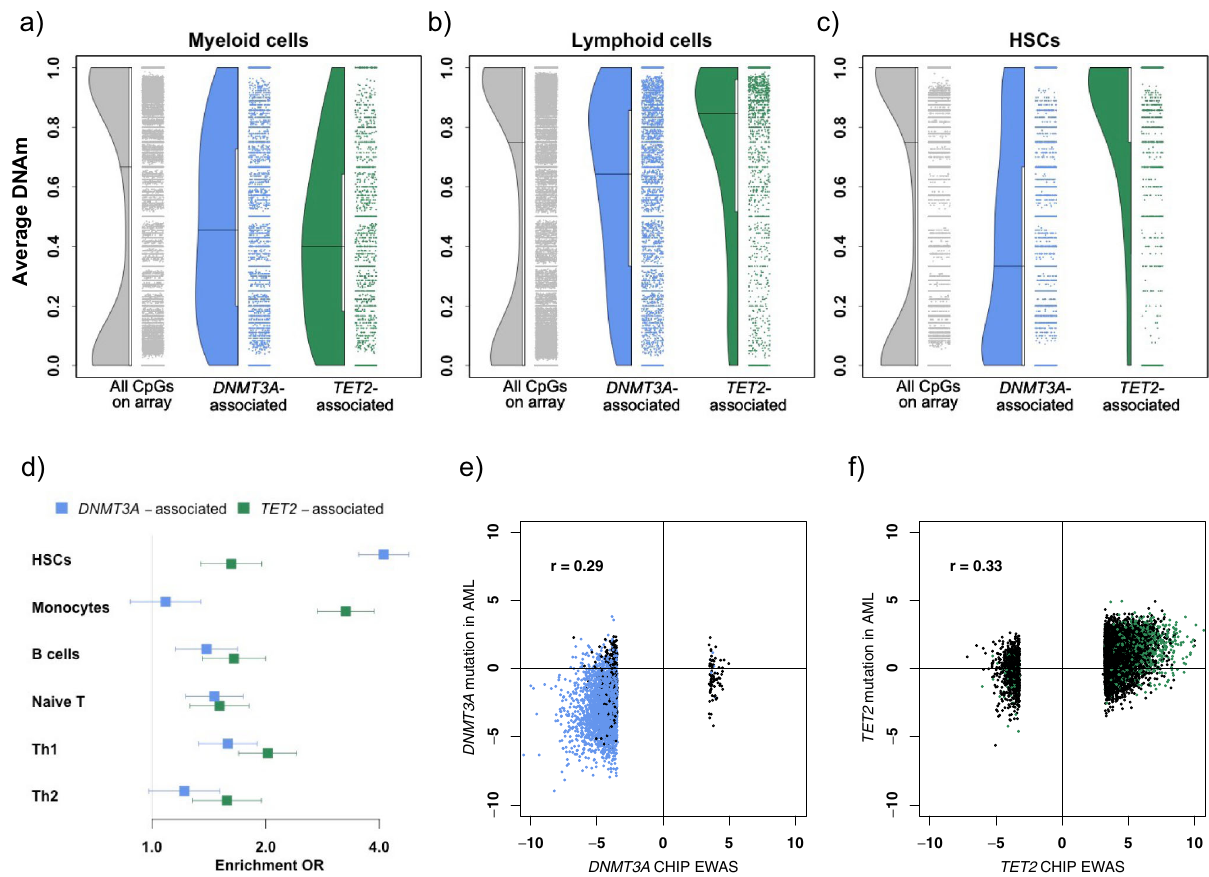
Fig. 2 | Enrichment patterns among DNMT3A - and TET2 -associated CpGs. a – c Distributionof average methylationlevelsestimatedfrom external WGBSdata formyeloid cells( a ),lymphoid cells( b ),andHSCs( c )forthreesetsofCpGsites:all CpGsonIllumina450Karray(gray),and CpGsshowing replicatedassociationwith DNMT3A CHIP(blue)or TET2 CHIP(green).EachpointrepresentsaCpG,while fi lled curvesshowthedensityfunctioncorrespondingtoallCpGsineachset.Horizontal lines indicate median of distribution. Because of the large number of CpGs con- sidered ( N =478,661), all pairwise comparisons between cell types were signi fi cant (Two-sidedWilcoxon P <2×10 − 16 ). d Enrichmentincell-speci fi cDHSamongthetop 1000 DNMT3A - or TET2 -associated CpGs, compared to 1000 random genomic- context-matched CpGs (one-sided binomial test; N =2000). Estimated OR (x-axis,